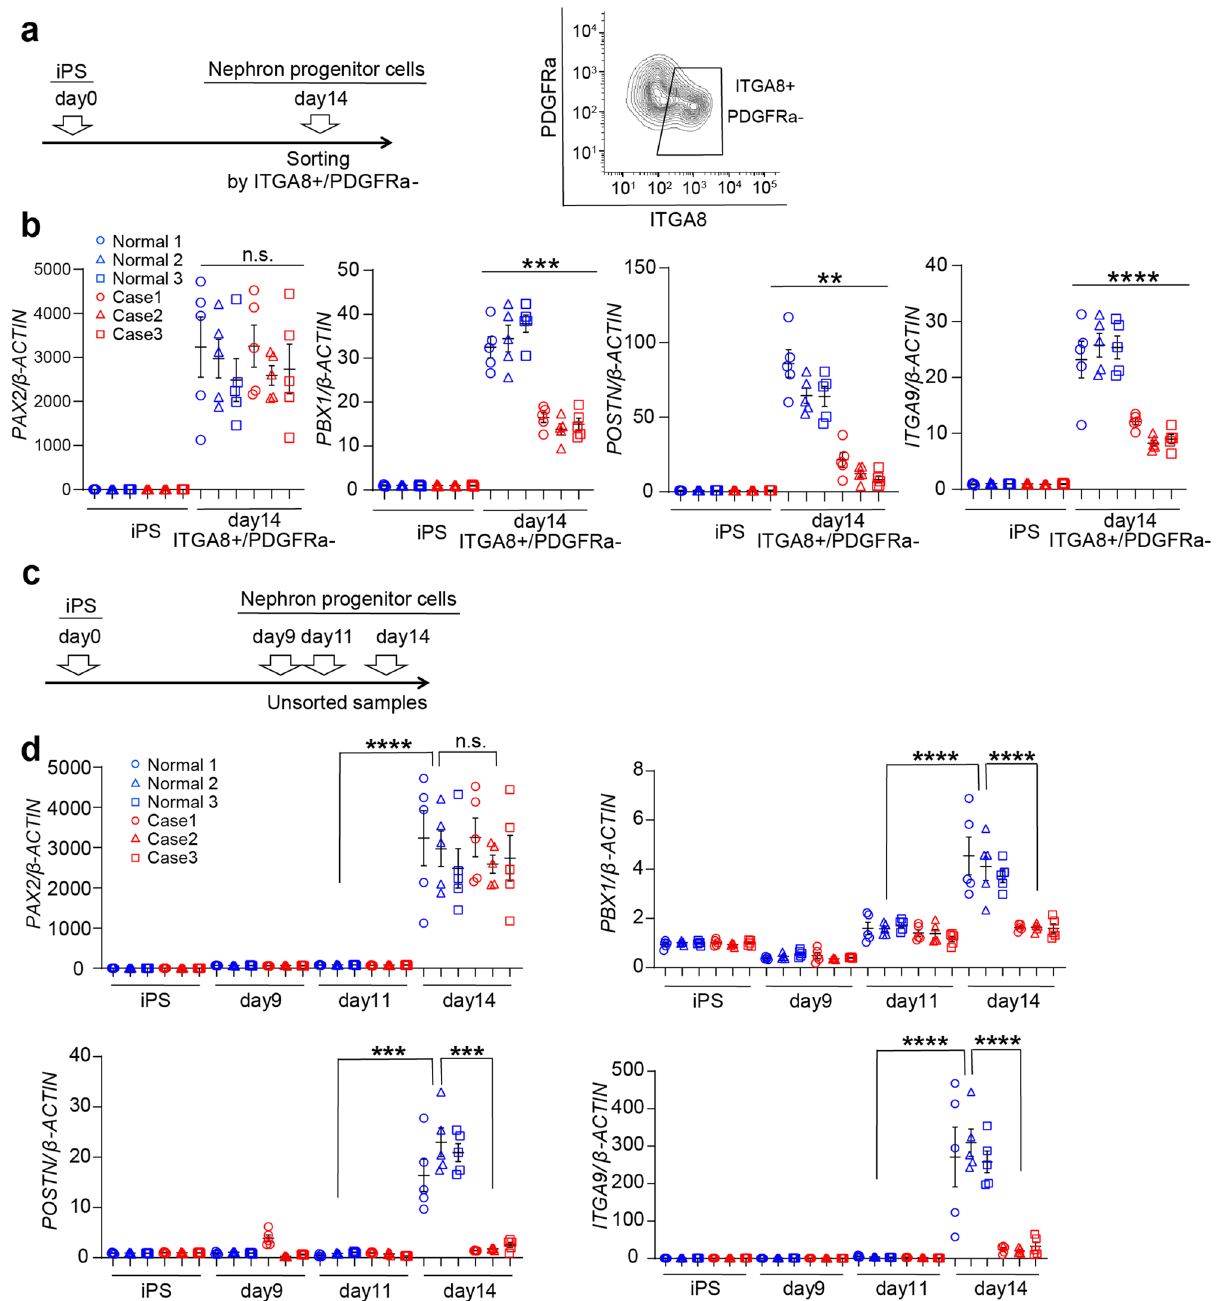
Figure 5. Identification of candidate PAX2 -regulated kidney development genes by quantitative reverse transcription-polymerase chain reaction (qRT-PCR). ( a ) mRNA samples were collected on iPSCs and sorting nephron progenitor cells using the surface markers INTEGRINα8+ PDGFRα−. ( b ) mRNA expression levels of PAX2 and candidate genes on iPSCs and sorted nephron progenitor cells using the surface markers INTEGRINα8+ PDGFRα−. ( c ) mRNA samples were collected on iPSCs, day 9, day 11, and day 14. ( d ) mRNA expression levels of PAX2 and candidate genes during induction of control and RCS-iPSCs to nephron progenitor cells in vitro. Data are expressed as mean ± SEM, n = 5 per group. Comparison of gene expressions between days 11 and 14 in healthy control samples was evaluated using Student’s t-test. Comparison of gene expressions between healthy control and RCS samples on day 14 was evaluated using Student’s t-test. *Statistically significant, ** P < 0.01; *** P < 0.001; **** P < 0.0001. n.s. not